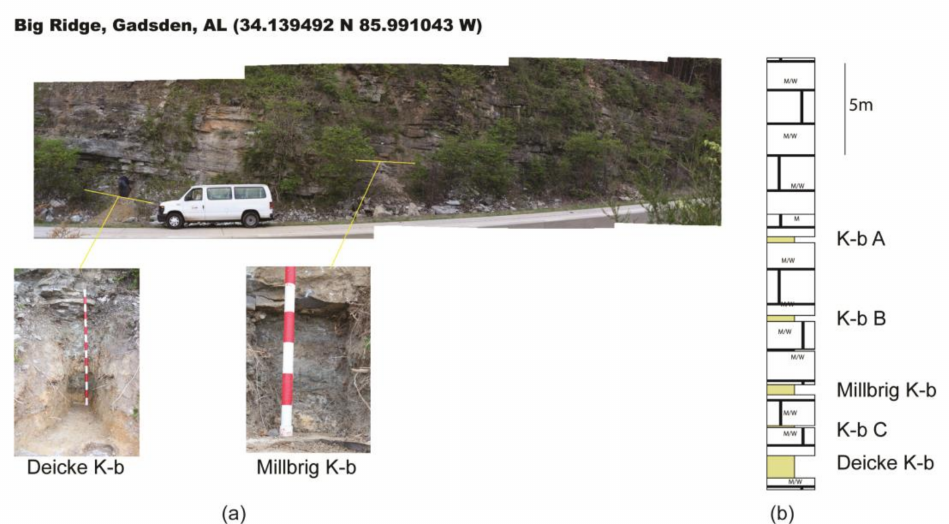
Figure 2. ( a ) The exposure of outcropping K-bentonites at Big Ridge, with insets of the Deicke and Millbrig K-bentonites showing the individual distinct layers that are evident subsequent to being completely excavated prior to collecting samples from each visibly different layer. ( b ) Stratigraphic column of the Big Ridge section, showing the stratigraphic horizons of individual K-bentonites used for developing the identification model using LA-ICP-MS data. K-b = K-bentonite. Recessed intervals (yellow) are K-bentonites. M: Mudstone; M/W: Mud/Wackestone. Red and white intervals on Jacob’s Staff are 10 cm